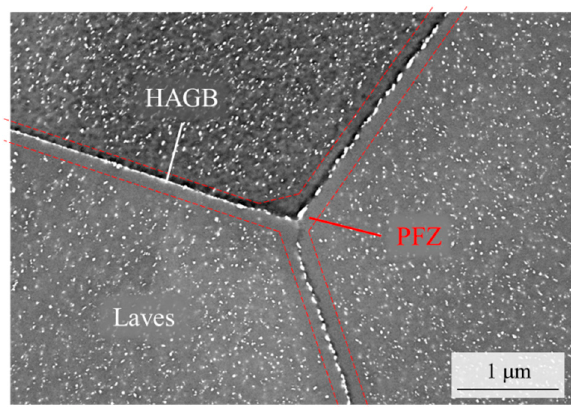
Figure 2. SEM micrograph of precipitated ferritic, stainless Crofer ® 22 H steel (taken after 2000 thermomechanical fatigue (TMF) cycles, cf. Section 3).